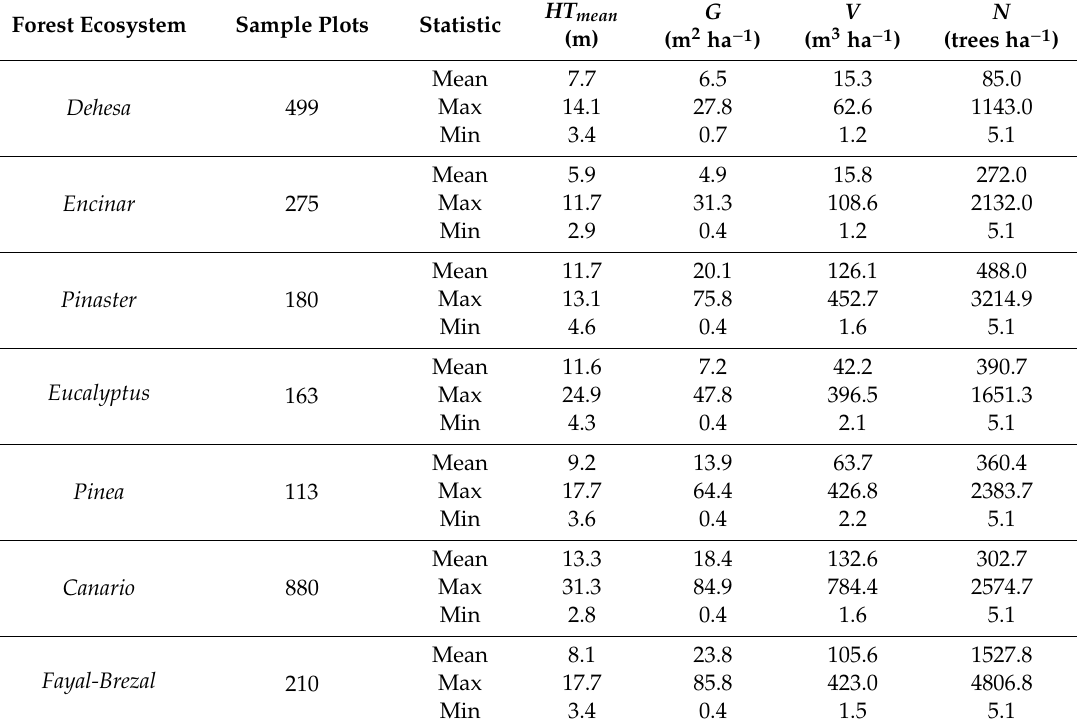
Table 1. Summary of ground data collected in the 4th National Forest Inventory (NFI) for the seven forest ecosystems. Plot-level estimates are presented for stand basal area ( G , m 2 ha − 1 ), tree density ( N